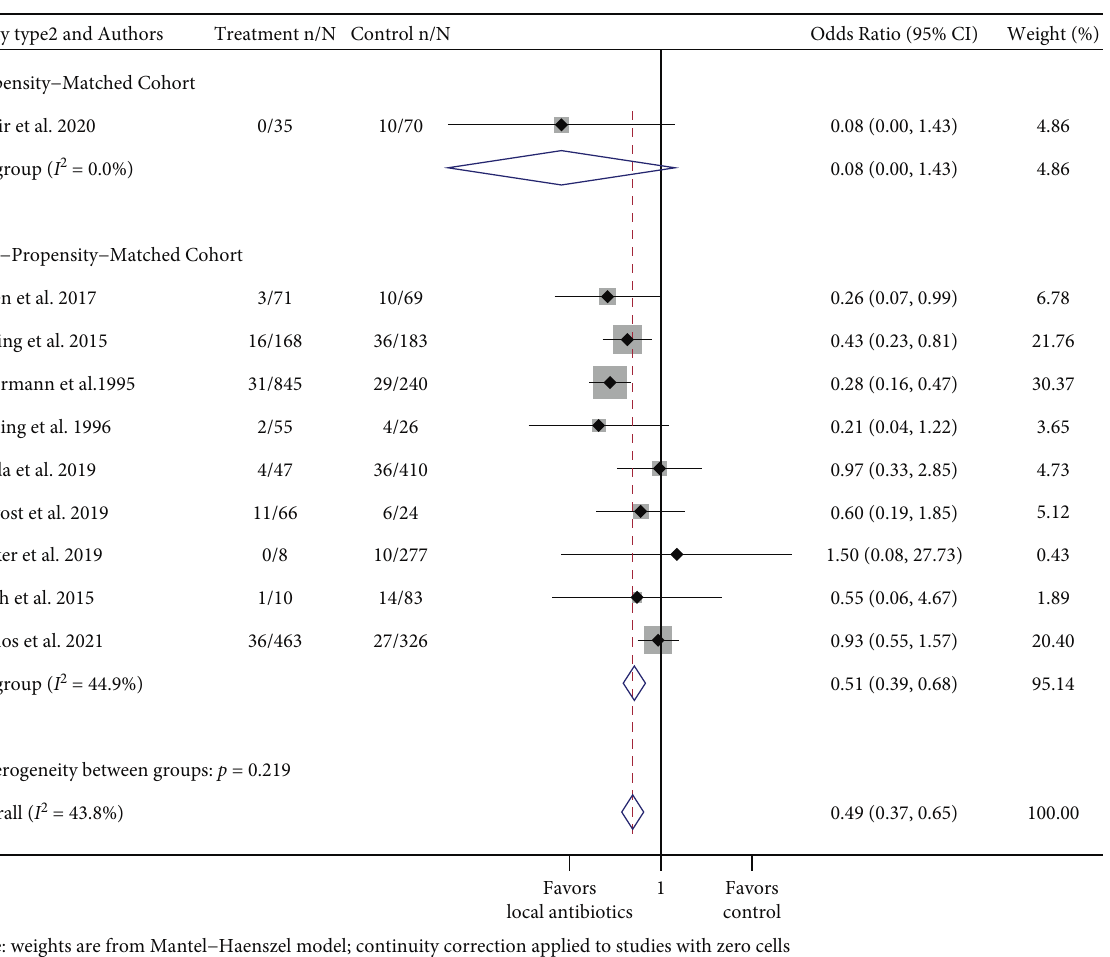
Figure 5: Forest plot of observational fracture studies. Treatment n/N: number of infections in the treatment group/total number of patients in the treatment group. Control n/N: number of infections in the control group/total number of patients in the control